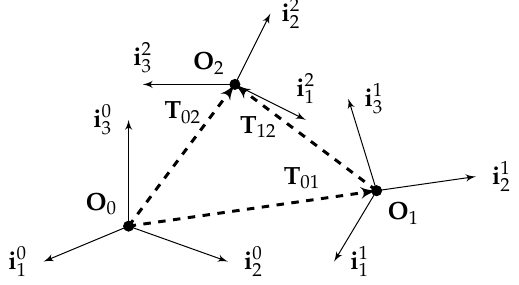
Figure A1. Reference system for combination of